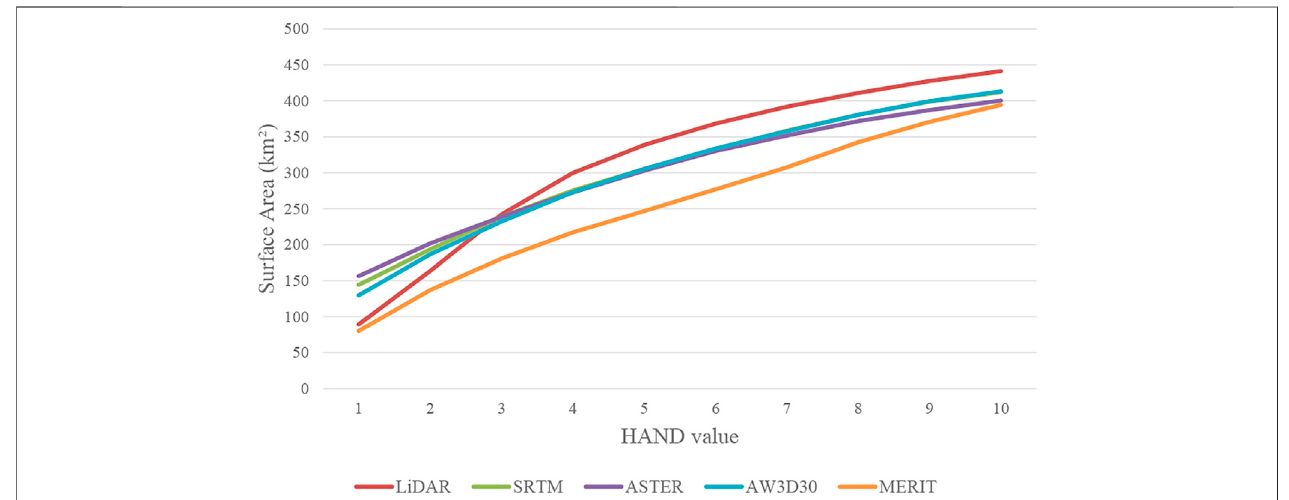
FIGURE 4 | Differences in fl ood extent as the fl ood depth increases from 0 to 10 m for the LiDAR and global DEMs.